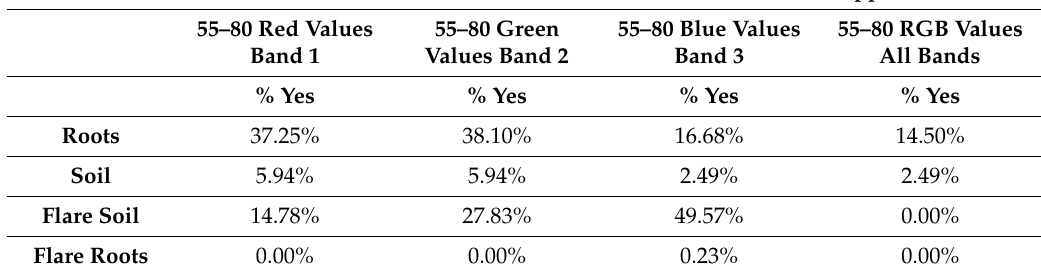
Table 1. Accuracy assessment for the root classification e ff ort listing the percentage of time that a commission error occurred for a given class by